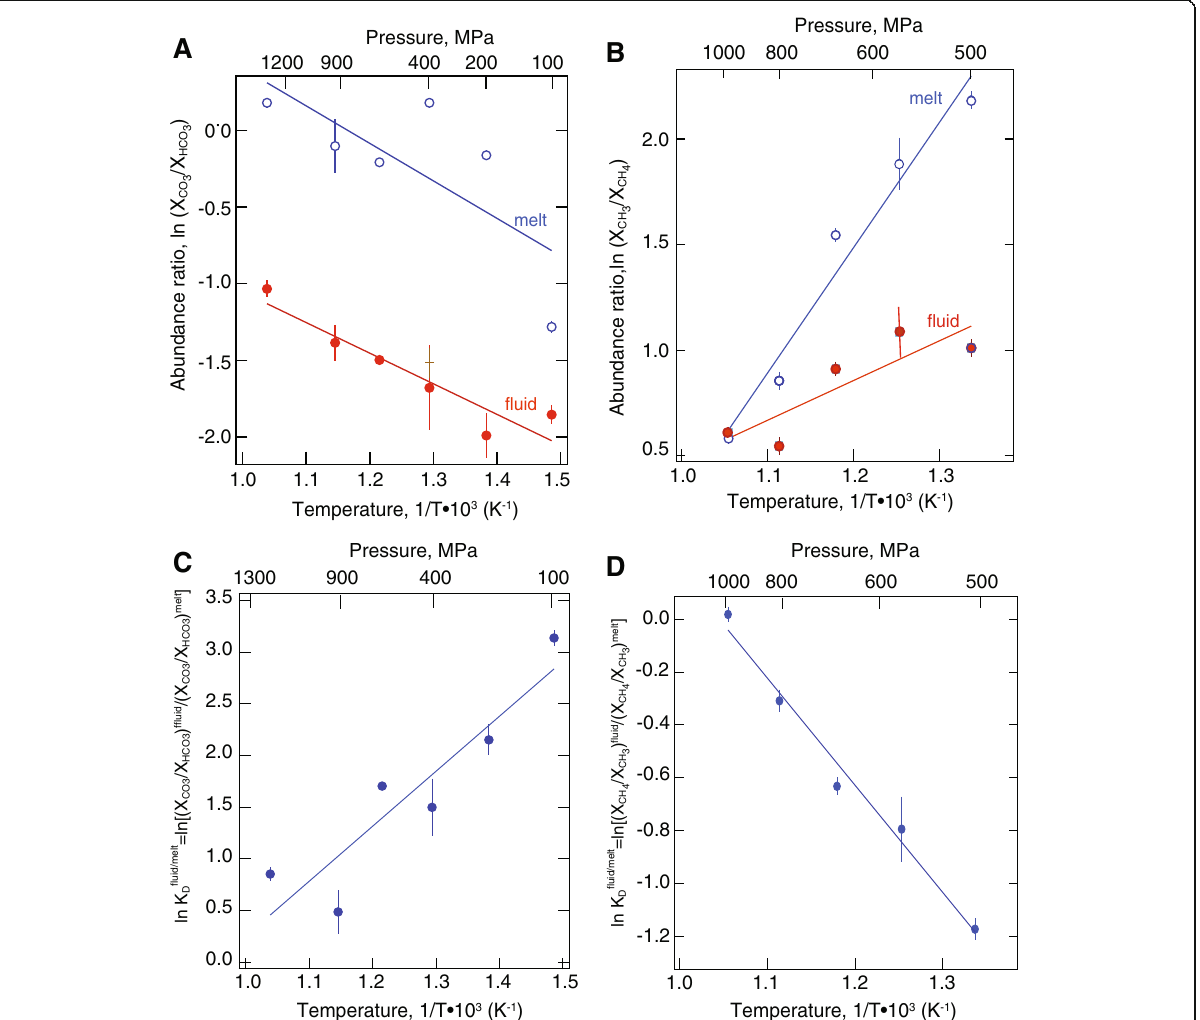
Fig. 3 Abundance of C-bearing species in coexisting COH fluids and melts as a function of temperature and pressure as indicated. a Evolution of carbonate species under oxidizing conditions. b Evolution of C-bearing species under reducing conditions. c Evolution of fluid/melt exchange of carbonate species under oxidizing conditions. d Evolution of fluid/melt exchange of C-bearing reduced species under reducing conditions. Note that temperature is the independent variable with pressure evolving as a function of temperature as described briefly in the text and in more detail in the original sources (modified after Mysen 2015a, 2015b). The Δ H values derived from the linear regression of the data are discussed in the text. In calculated these Δ H values, it was assumed that there is no pressure effect on these